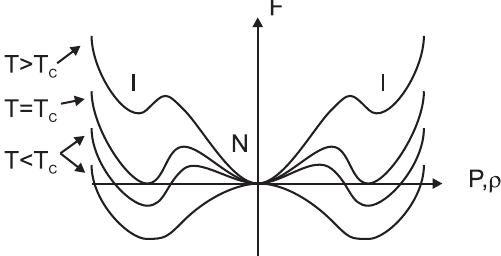
Figure 32. The free energy of a first-order transition is depicted as a function of the order parameter (for instance polarization, ionicity) for various temperatures at the vicinity of the phase transition. At the transition, several minima